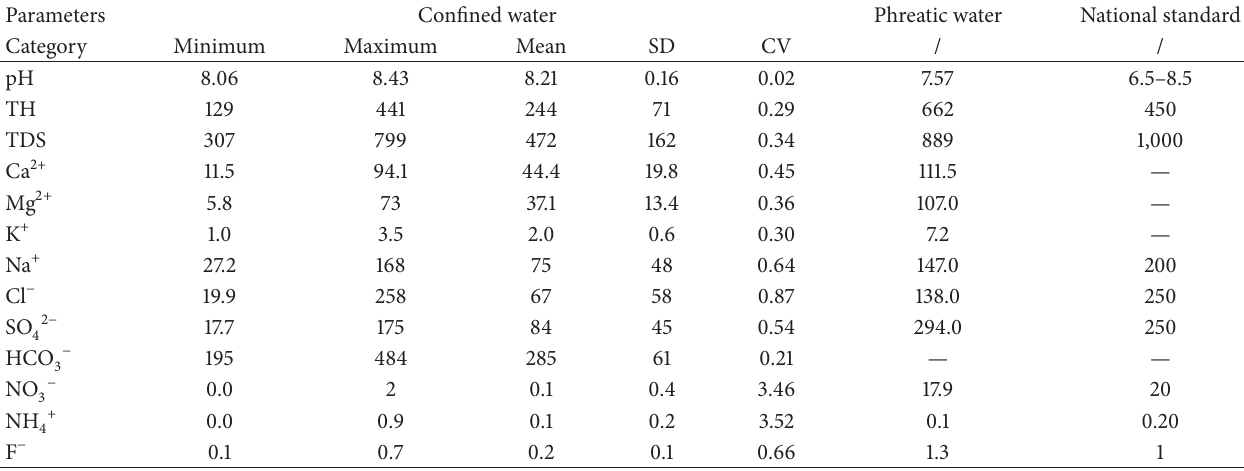
Table 1: Descriptive statistics of hydrochemistry in Yinchuan,